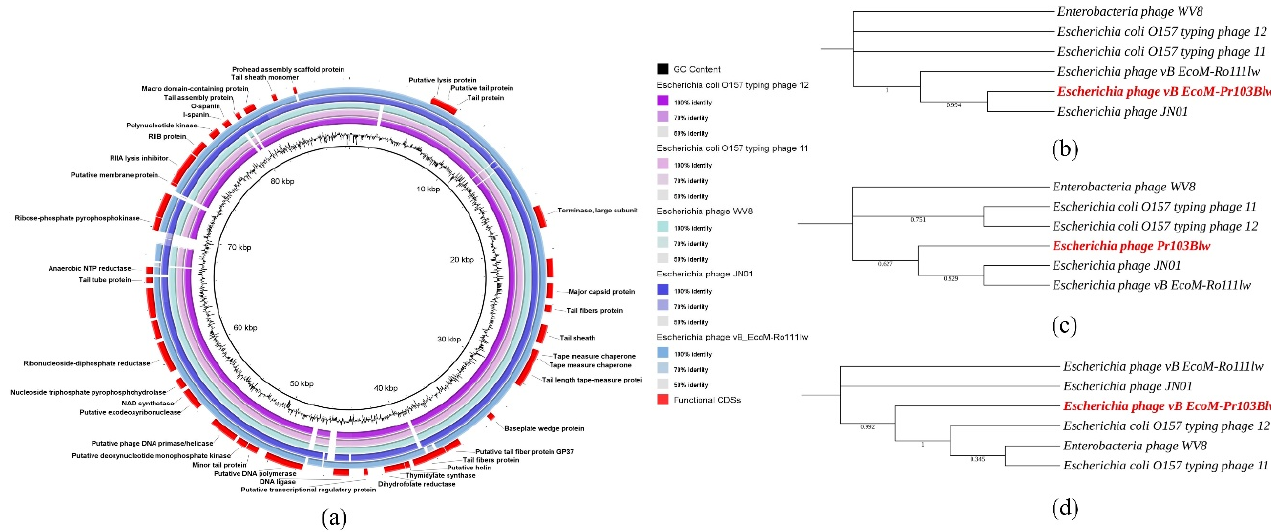
Figure 6. Genomic relationships between Pr103Blw and its five closely related reference phages. ( a ) Whole-genome comparison of Pr103Blw and five reference phages using blastn and visualization with BLAST Ring Image Generator (BRIG). The color key coding for five circular maps of reference phage genomes with high sequence identity to Pr103Blw genome is illustrated in the legend, and the gradients of each color indicate the sequence identity, ranging from 50–100%. The CDSs with the predicted functions from the phage Pr103Blw are displayed in the outermost ring with red color. ( b – d ) Maximum likelihood phylogenetic analysis of Pr103Blw (highlighted in red) and the five closely-related reference phages based on the MAFFT alignment of the CDSs associated with ( b ) infection (tail fibers), ( c ) host cell lysis (lysin and holin), and ( d ) DNA packaging (terminase). Numbers next to the branches are bootstrap values (500 replicates).